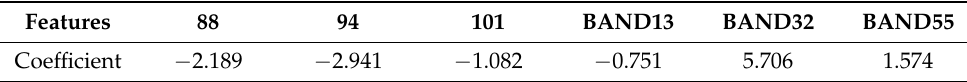
Table 5. Interaction characteristic coefficients of water body.